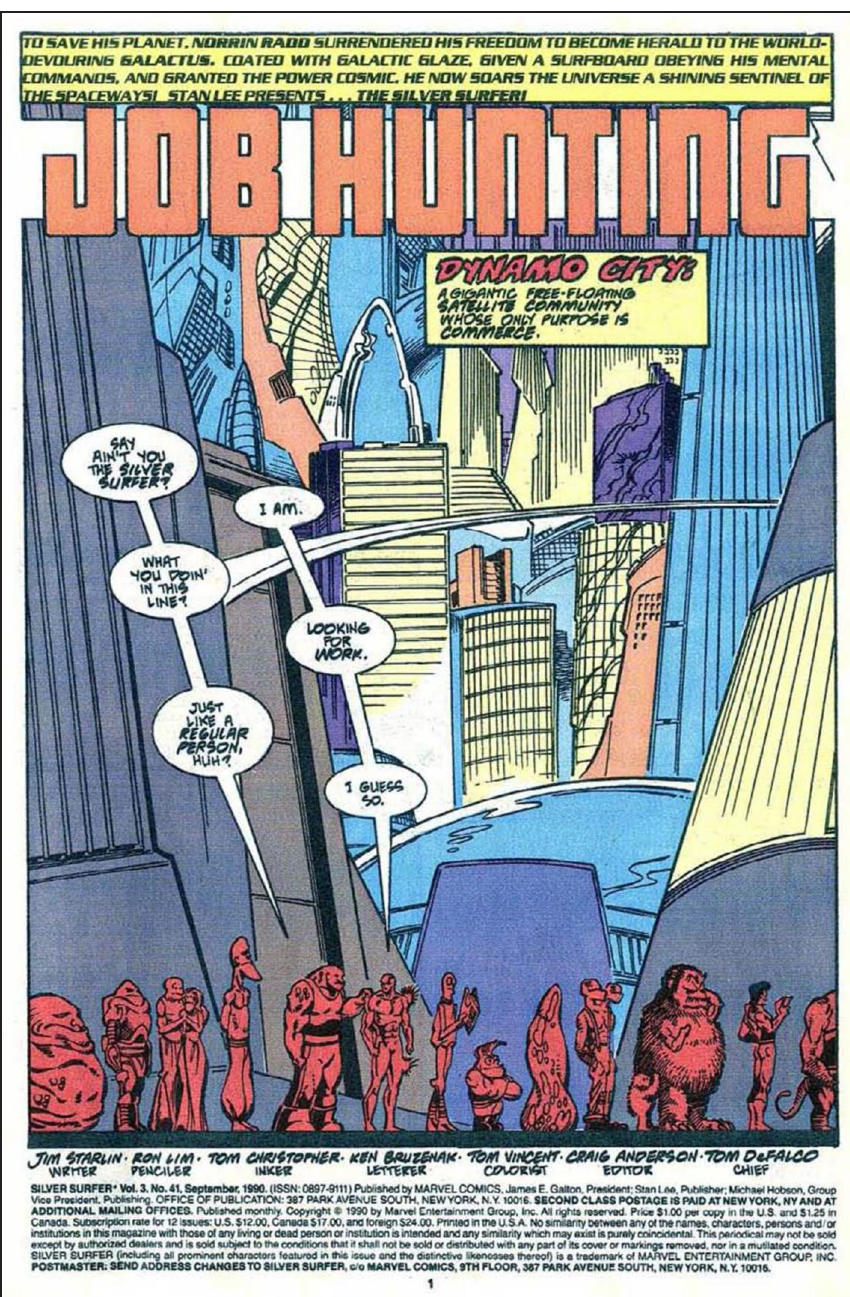
Figure 1: The Silver Surfer #41. New York: Marvel, 1990, p. 1. Jim Starlin (writer), Ron Lim (penciler), Tom Christopher (inker), Ken Bruzenak (letterer), Tom Vincent (colorist), Craig Anderson (editor), Tom Defalco (Chief). © 1990 Marvel Entertain- ment Group,